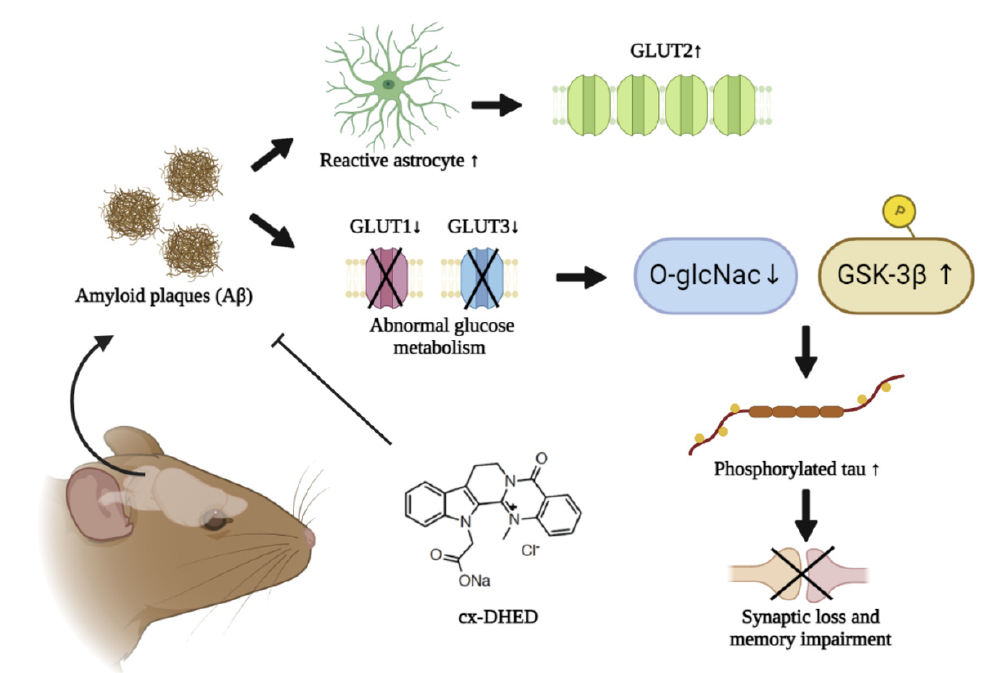
Figure 7. Study summary. In the brain of 5xFAD mice, accumulation of amyloid plaques (A β ) per- turbs normal glucose metabolism by driving a reduction in glucose transporters 1 and 3 (GLUT1 and GLUT3, respectively) or overexpression of GLUT2 by upregulated reactive astrocytes. While phosphorylated GSK-3 β was increased, O-GlcNac was diminished by dysfunctional glucose metabolism. Consequently, increased phosphorylated tau leads to synaptic loss and memory impairment. However, cx-DHED treatment attenuated the formation of amyloid plaques and upregulated O-GlcNac, as well as the level of GLUT in the brain of 5xFAD mice. Finally, cx-DHED treatment led to the reduction in phosphorylated tau and recovery of memory function.